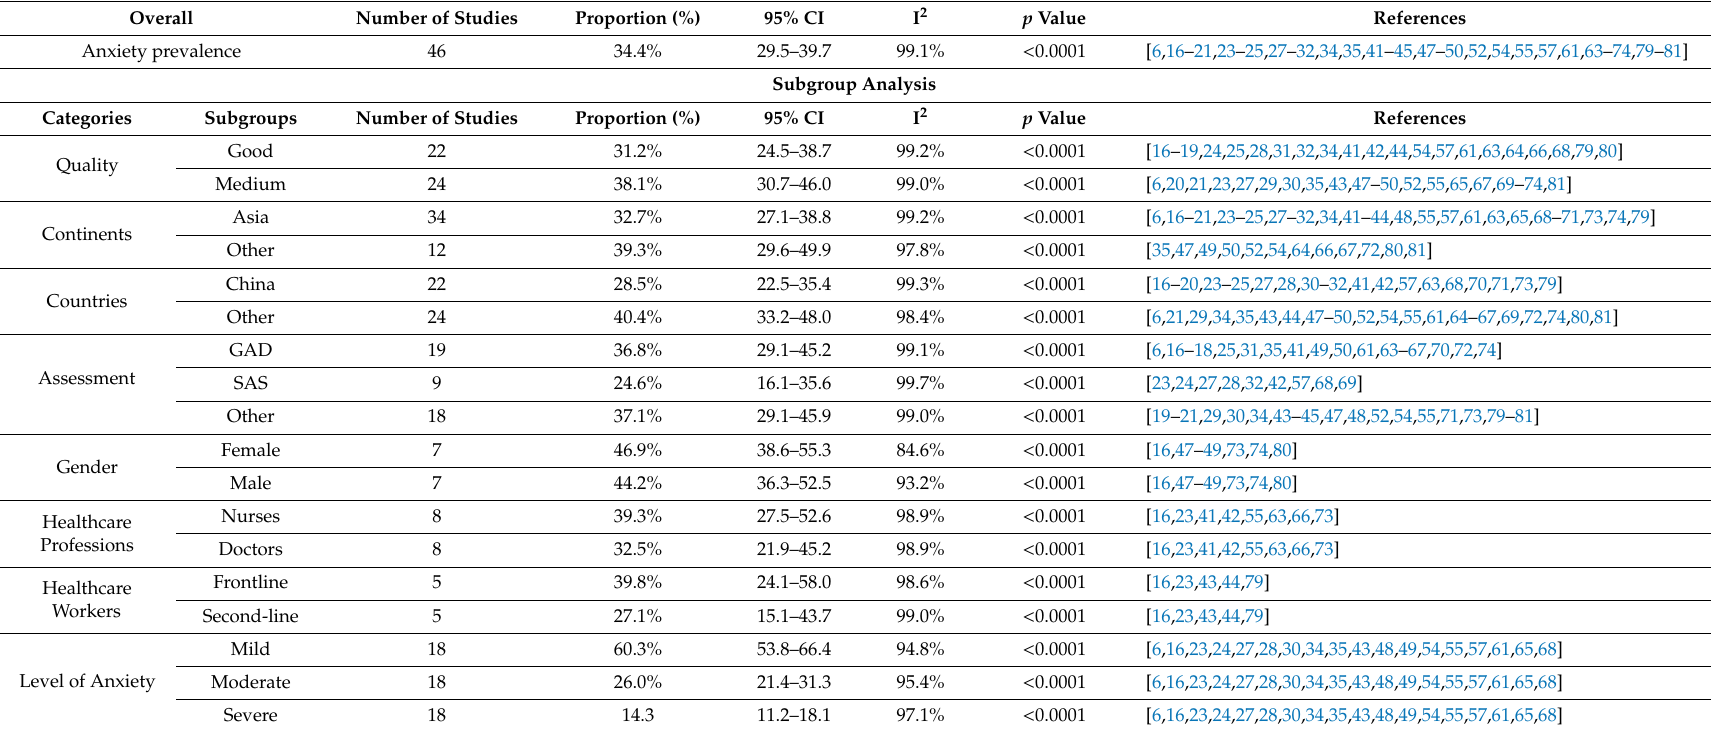
Table 1. Subgroup analyses of anxiety across di ff erent